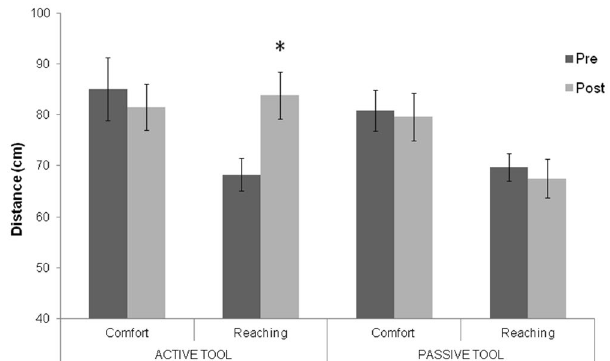
Figure 5. Effects of tool use training on comfort and reaching-distances. Statistical comparison of average distances (cm) in the two tasks (comfort and reaching judgment) in the two Tool training conditions (Active and Passive) and in the two Sessions (pre and post training). Error bars indicates standard errors of the mean. The asterisk indicates a significant difference in the reaching distance before and after active tool